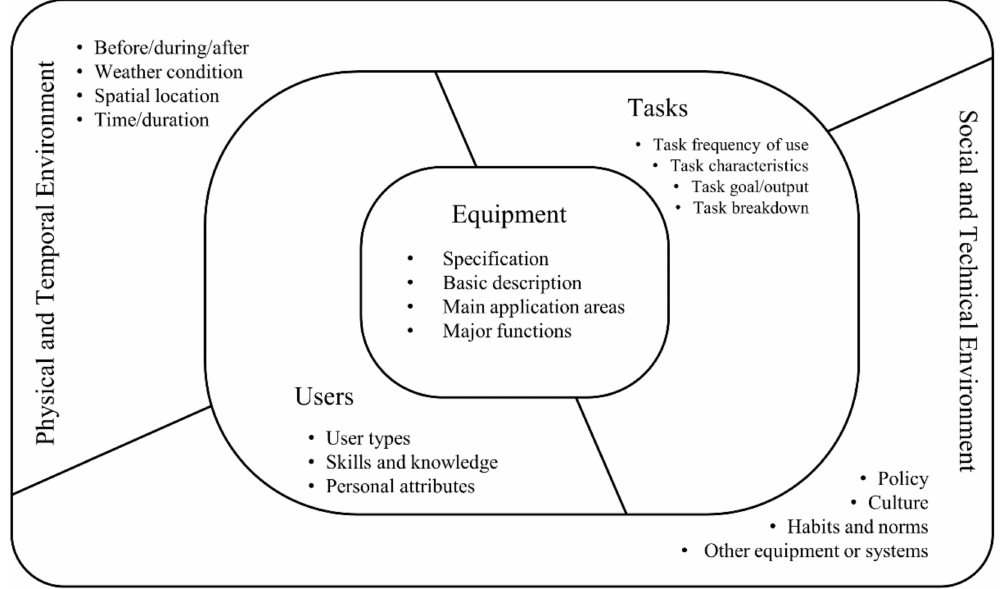
Figure 1. Context of use based on ISO 9241-210 and ISO